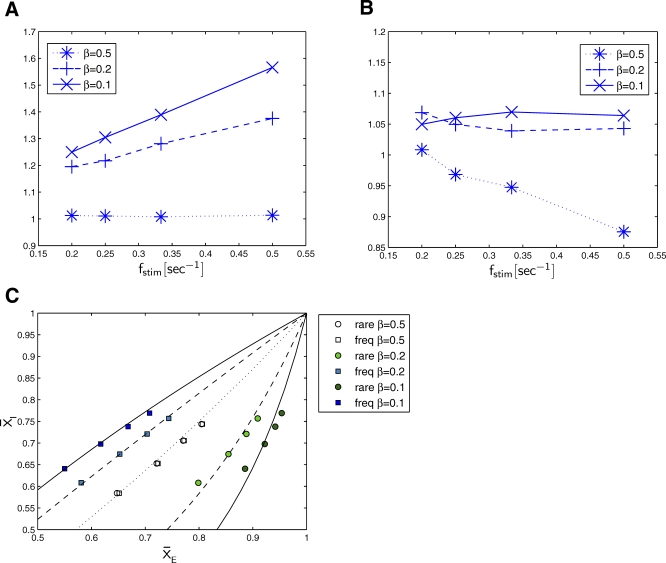
Selective Adaptation in Simulated NetworksResults are averaged from 10 different random networks.(A,B) Dependence of selectivity (as defined in Equation 13) and amplification (as defined in Equation 14) on stimulation frequencies and relative intensity. For frequent-rare ratios greater than 1, selectivity increases with stimulation frequency. However, amplifcation (increased sensitivity to the rare) is pronounced only for high ratios. Both results agree with the theoretical predictions presented in Figure 4.(C) Dependence of the fixed point loci for the frequent (squares) and rare (circles) sites on frequencies and ratios. For a 1:1 ratio (β = 0.5), both sites are identically stimulated and so converge to the same fixed point in the phase plane. As β is decreased, ρrare decreases while ρfreq increases. The curves were fitted according to Equation 9, values of ρ for each curve were found by trial and error: for β = 0.1, ρrare = 0.2, and ρfreq = 1.45 (solid lines); for β = 0.2, ρrare = 0.35 and ρfreq = 1.1 (dashed lines); for β = 0.5, ρrare = ρfreq= 0.75 (dotted line). Using the identity ρ
0 = ρrare + ρfreq we can estimate that for this system ρ
0 ≈ 1.5.